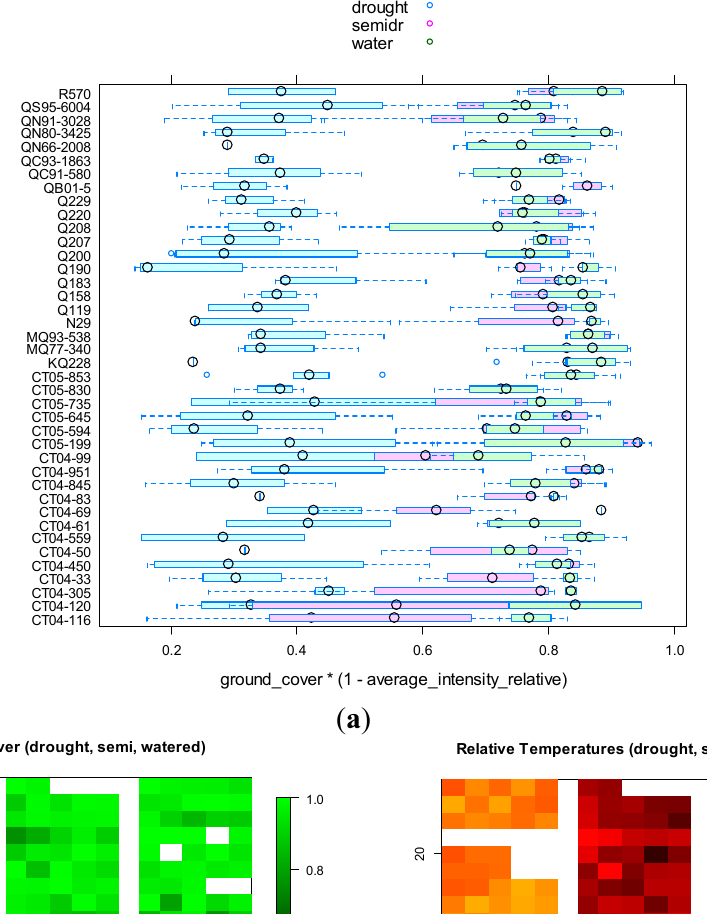
Figure 6. ( a ) Approximation of the potential transpiration index for 40 clones of sugarcane in three different drought treatments (drought, semi-drought and irrigated) based on green leaf cover and relative crop temperature, as determined from images similar to that in Figure 4. Missing columns are “filler”, and missing plots had poor establishment or pigweed infestation and were eliminated based on inspection of the images. The upper figures are heatmaps of ( b ) the thresholded green cover estimates and ( c ) the relative crop temperature. Images were taken at 60 m of elevation on November 28, 2011, when the crop had just passed six months of